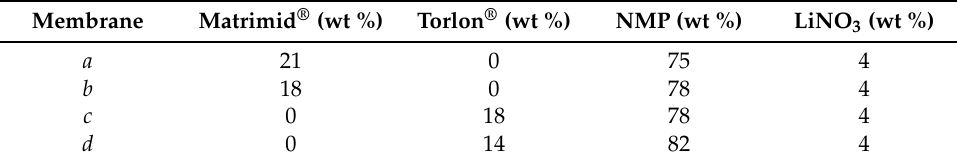
Table 1. Composition of the polymer